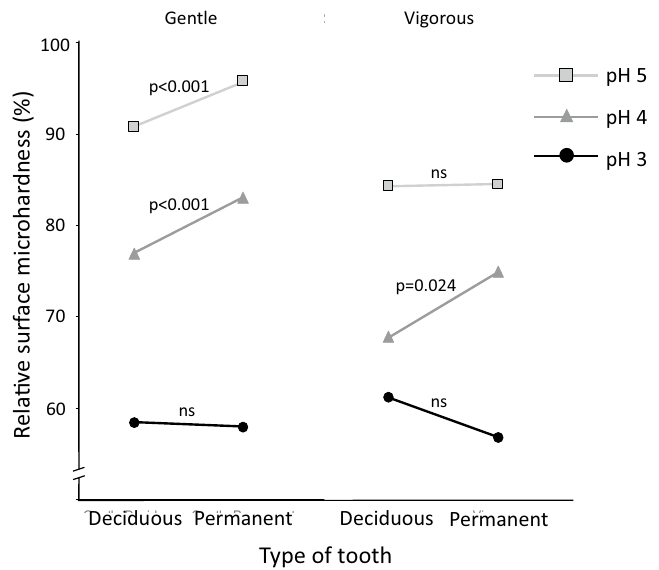
Figure 3. Differences in the relative surface microhardness (rSMH, %) between deciduous and permanent teeth, according to different pH values [pH 5 (squares), pH 4 (triangles) or pH 3 (circles)] and different agitations [gentle (left) or vigorous (right) shaking]. Significant differences between deciduous and permanent teeth are shown when p < 0.05, and “ns” is given when difference is not significant. To better visualize the results, the deviation values are not given here, but the complete data is displayed in Fig. 1.